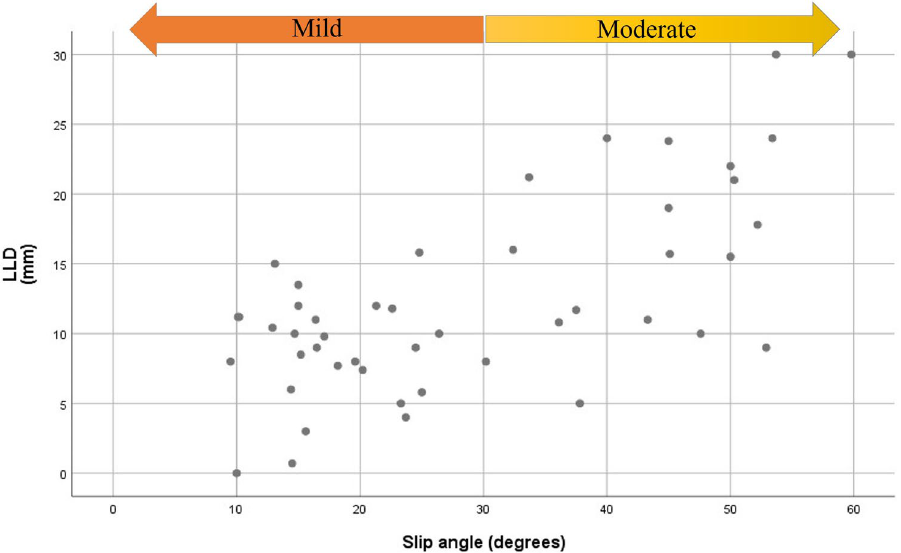
Figure 2. Scatterplot shows the relationship between slip angle and leg length discrepancy (LLD). The final degree of LLD was less than 1.5 cm in almost all patients with mild